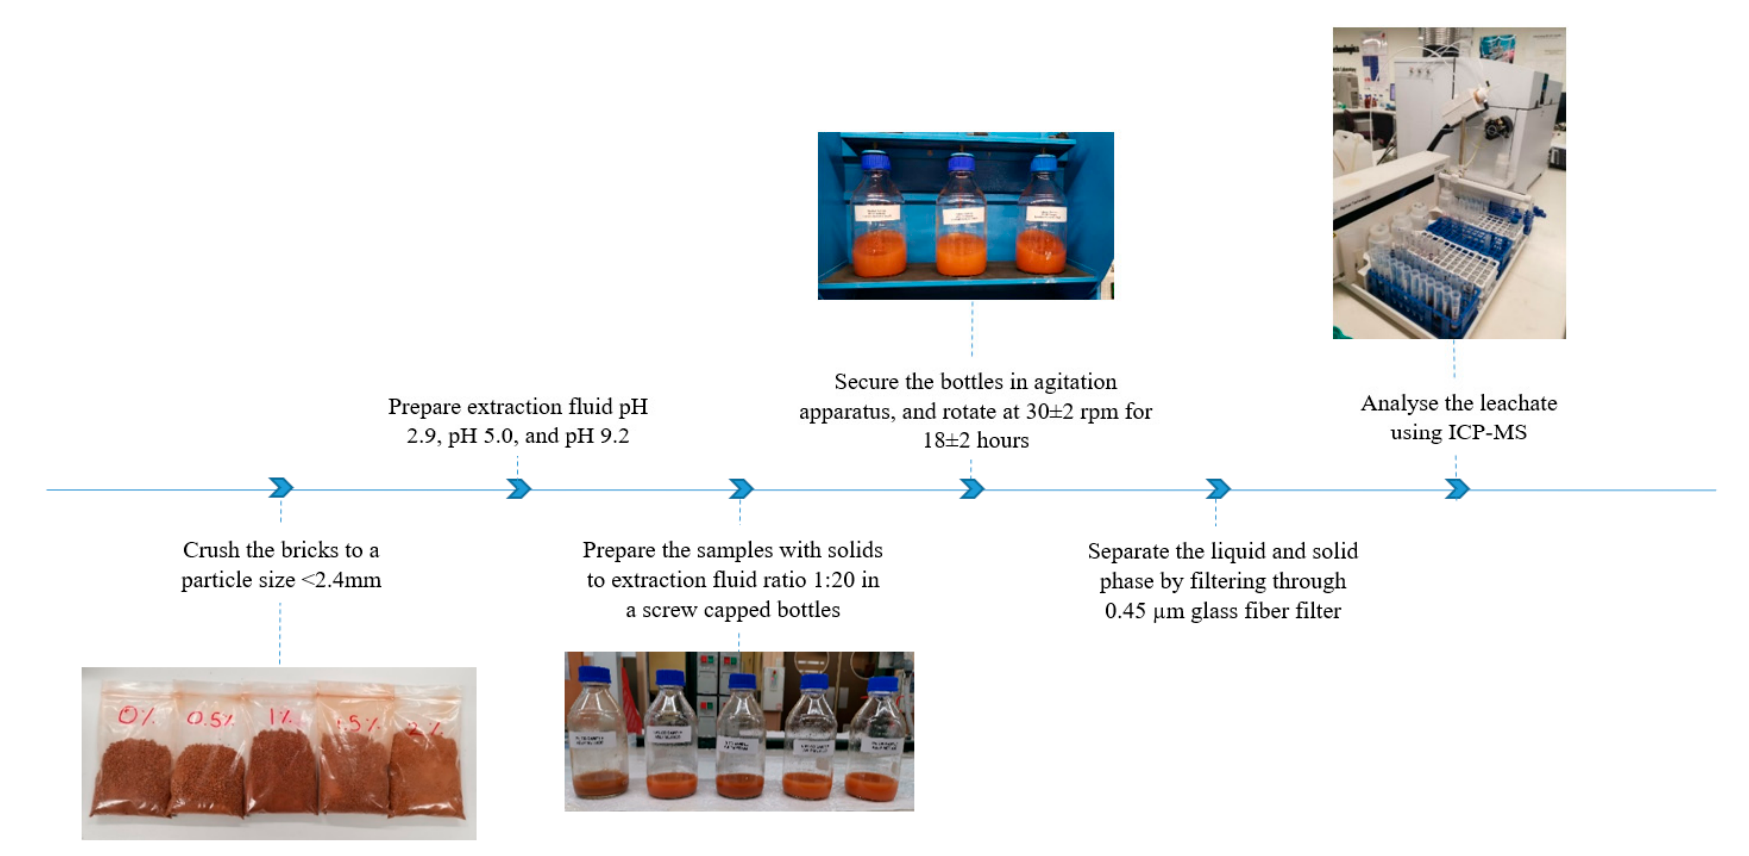
Figure 3. Flow chart of the leachate analysis procedure followed in this study.